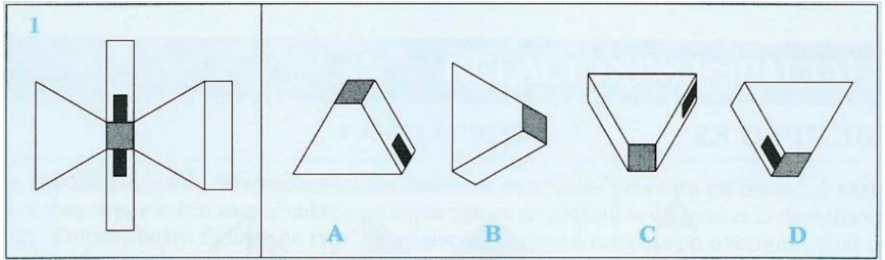
Figure 3. Example item in the Mental Rotation Test (MRT).